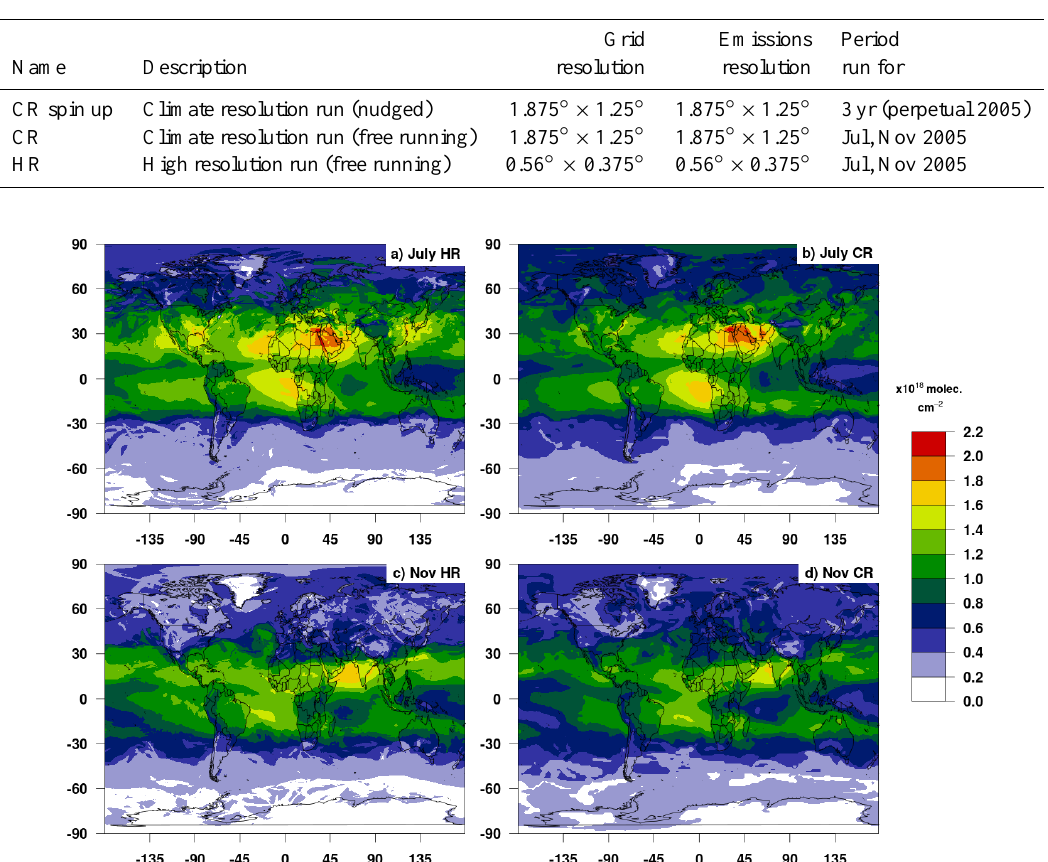
Fig. 1. Global distribution of monthly mean tropospheric ozone column from runs at high resolution HR and climate resolution CR for July and November 2005.